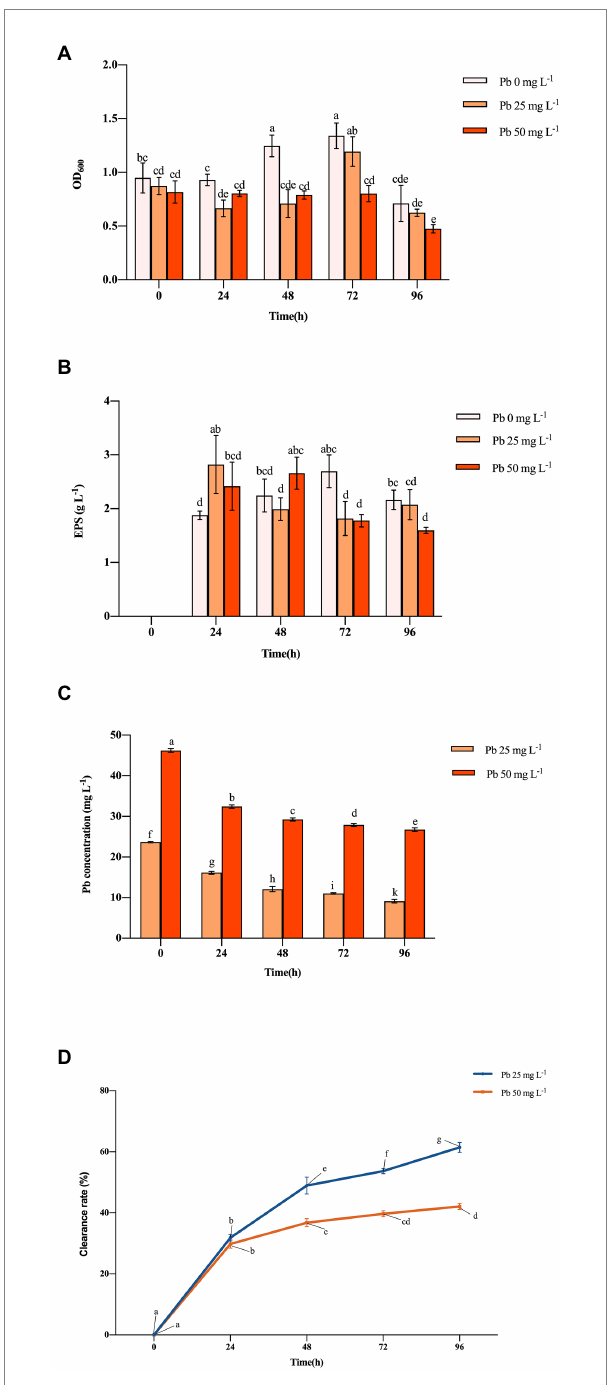
FIGURE 1 The cell number (indicated by OD 600 ) (A) , EPS (B) , Pb (C) content, and clearance rate of Pb (D) in the culture solution at different Pb concentrations inoculated with Hao 2018. Each bar represents the mean ± SD ( n = 4). The same letter indicates that there were no significant differences between all treatments ( p >